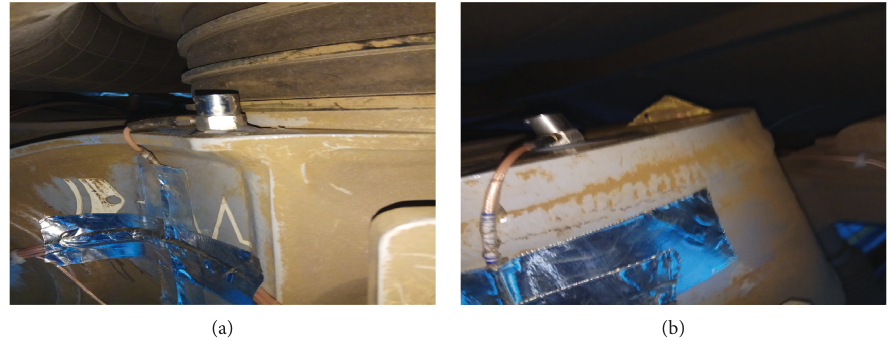
Figure 5: Site layout of a portion of the measuring points. (a) Air spring bogie frame. (b) Axle box-bogie frame.